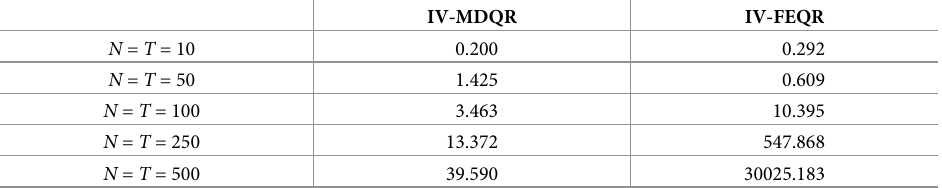
Table 3. The computing time (in seconds) of IV-FEQR and IV-MDQR estimators required for one replication under different sample